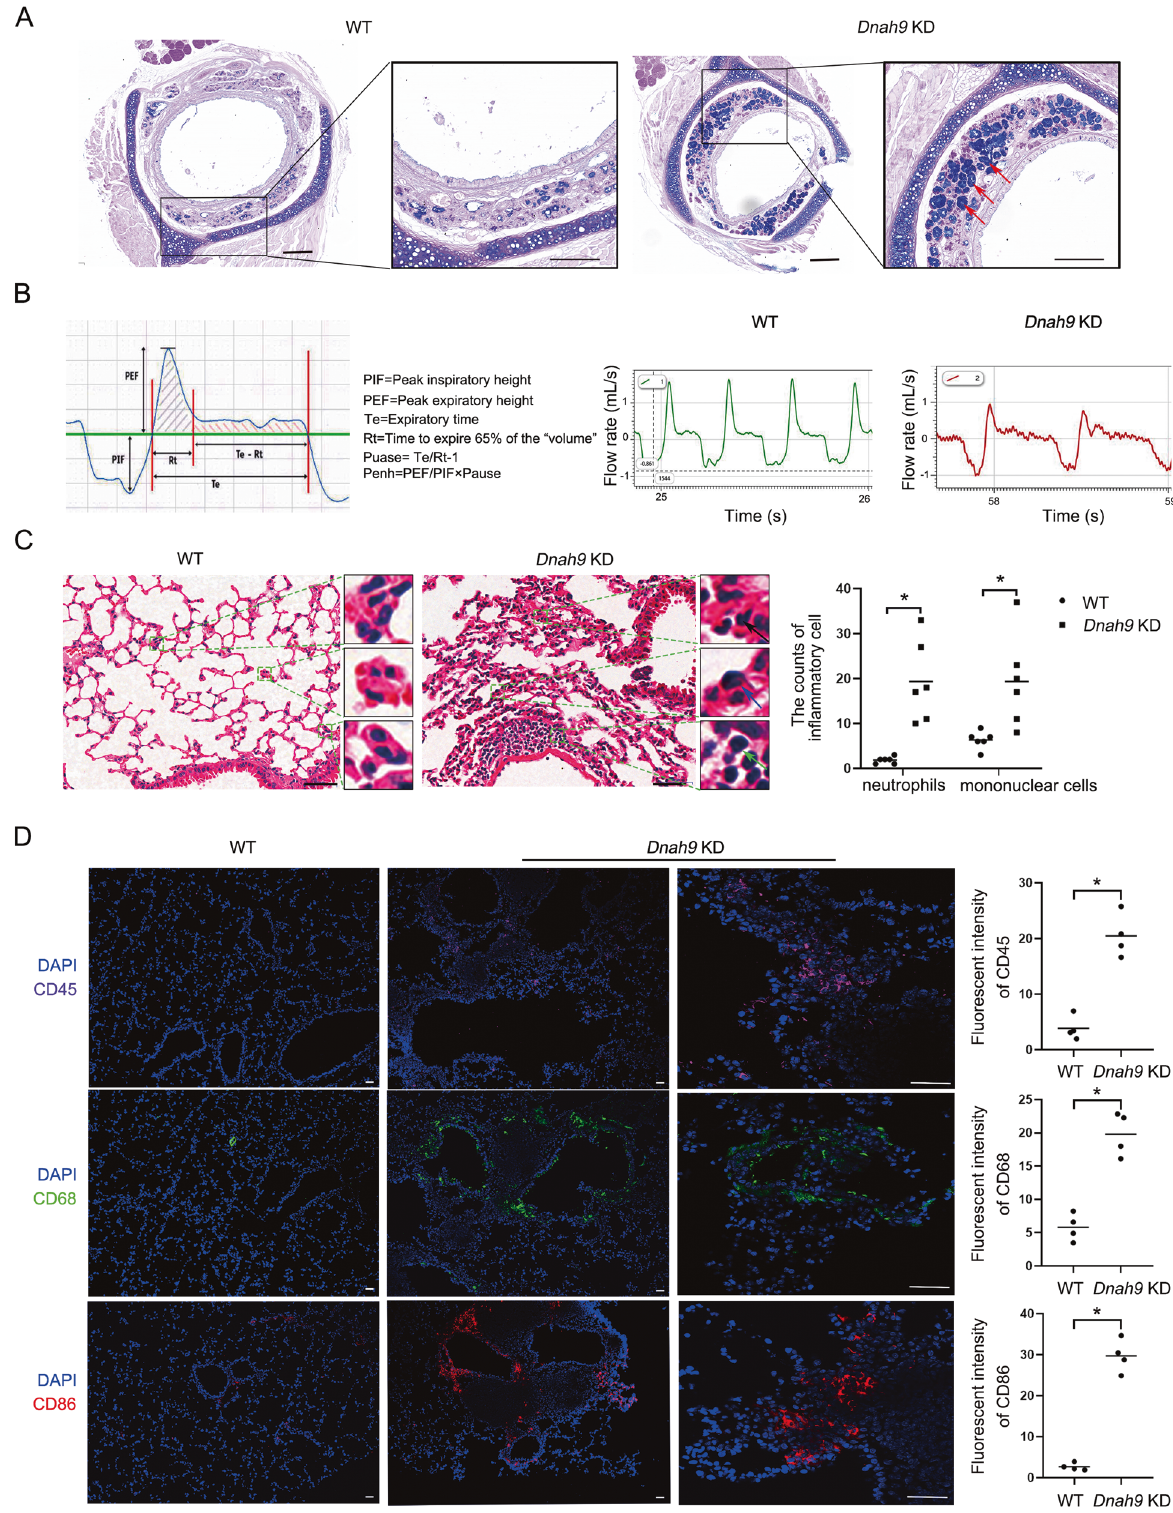
signi fi cantly reduced compared to that of the WT mice (Fig.